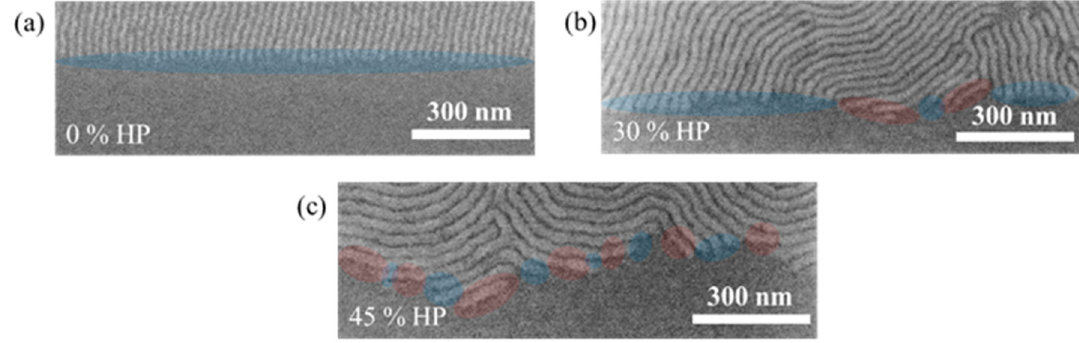
Figure A4. Grain boundary evolution as function of homopolymer content in the ternary blend. ( a ) 0% homopolymer, ( b ) 30%, ( c ) 45%; tilt grain boundaries and the blue areas are marked in red and twist grain boundaries are marked in blue.